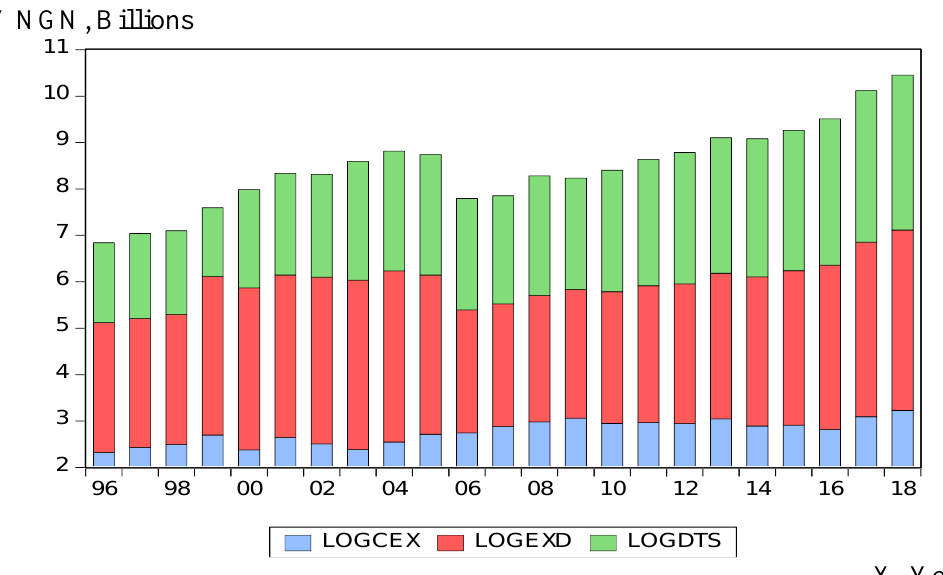
Fig. 5. Data trends from 1996 to 2018 (Central Bank of Nigeria Statistical Bulletin,